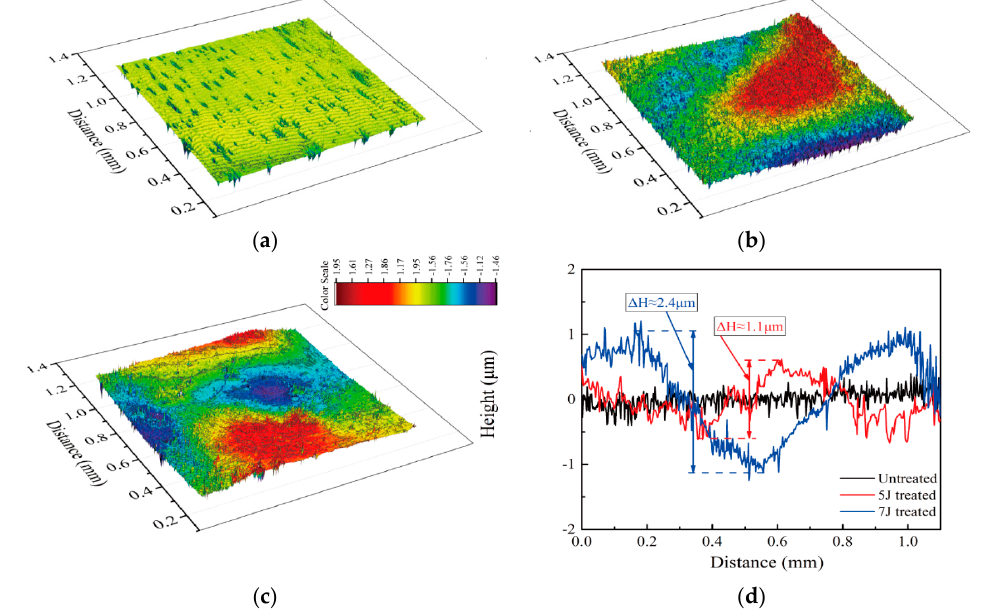
Figure 4. Surface morphologies of three samples. ( a ) Untreated; ( b ) 5 J treated; ( c ) 7 J treated; ( d ) 2D surface topography of three samples.